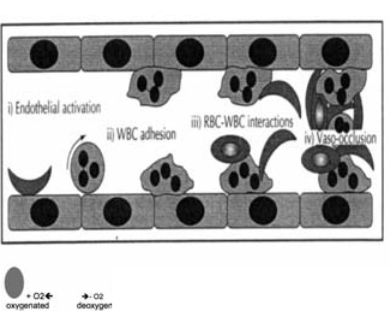
Figure 3. Red cell morphology. 16 Legend: RBC: red blood cells i) Endothelial activa- tion; ii) WBC adhesion; iii) RBC-WBC interactions; iv) vasoocclusion. Lumen obstruction results from interaction b/w WBC, RBC, platelets, plasma proteins & vascular endothelium.